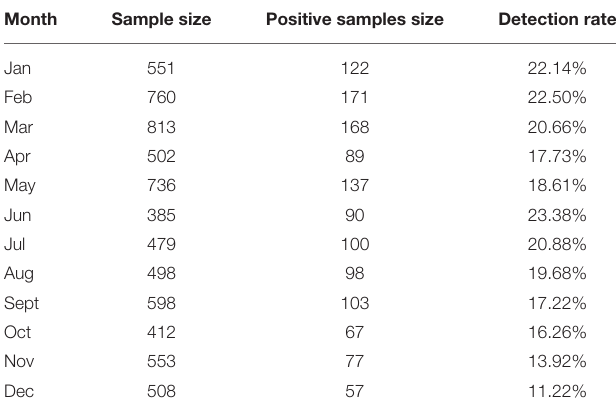
TABLE 4 | Monthly detection rate of PRRSV in South China between 2017 and 2021.